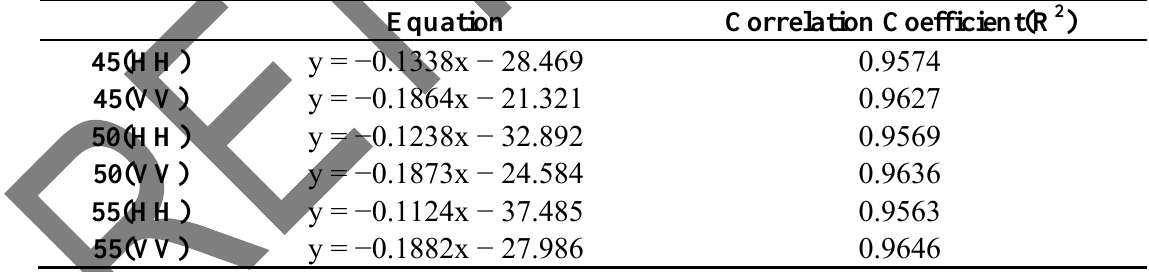
Table 2. Equations and correlation coefficients for three look angles (45º, 50º and